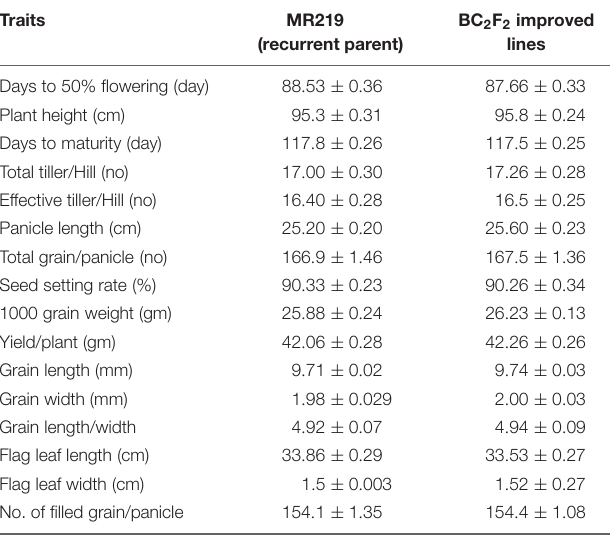
TABLE 8 | Performance of major agronomic traits of BC 2 F 2 improved lines carrying blast resistant (putative Pi-b and Pi-kh )